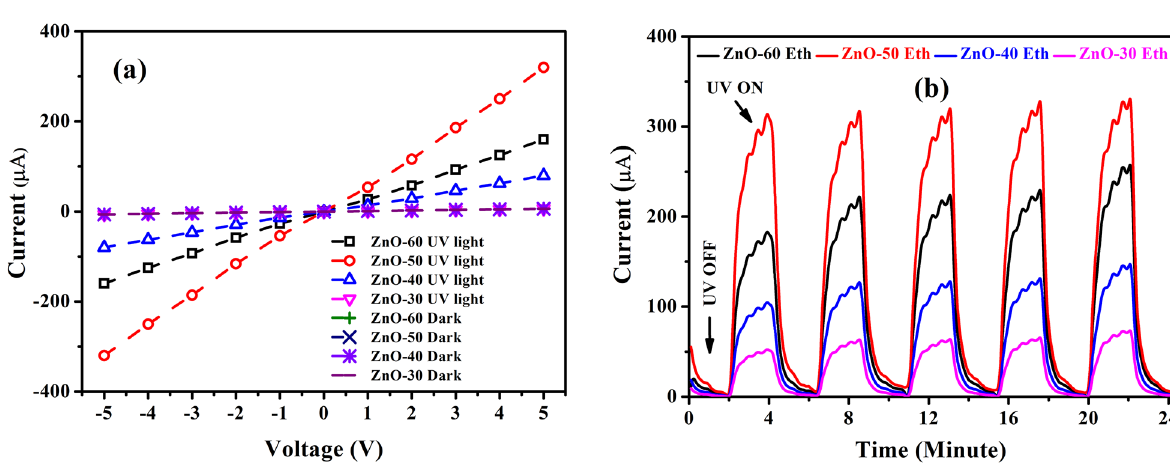
Figure 11. ( a ) I–V characteristics and ( b ) UV response of the ZnO thin films grown in ethanol as a function of time upon 2 mW/cm 2 illuminations at 5 V